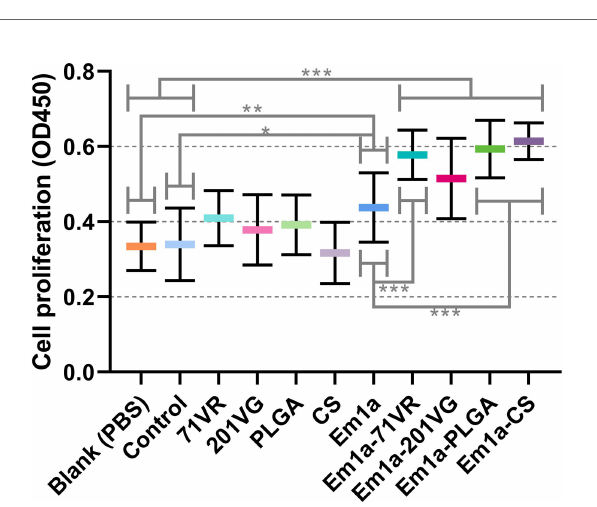
FIGURE 8 | The proliferation of splenic lymphocytes isolated from chickens. Five animals in each group were sacri fi ced, and the splenocytes from each animal were independently tested three times (n = 5). Values were estimated using one-way ANOVA followed by Dunnett ’ s test. Comparisons among Em1a, Em1a-71VR, Em1a-201VG, Em1a-PLGA, and Em1a-CS group were conducted by ANOVA following Bonferroni ’ s correction. Values were presented as the mean ± SD (n = 15). In all studies, * p < 0.05, ** p < 0.01, and *** p < 0.001.